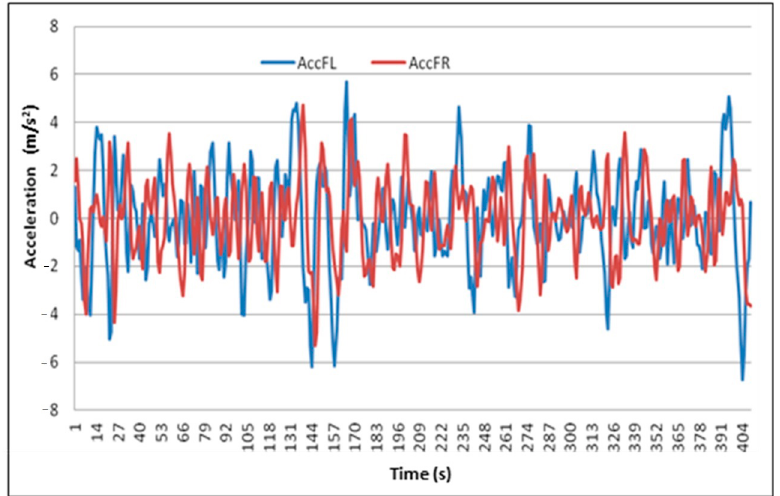
Figure 3. Original time histories of acceleration on two sides of a vehicle.